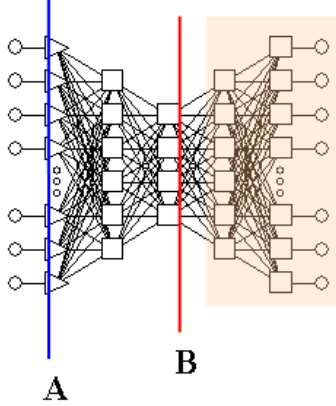
Figure 4. A neural auto-associative network implementing a nonlinear PCA transformation: A—input layer of the 5-layer auto-associative network; B—hidden layer of the 5-layer auto-associative network (compressing in a non-inear manner).